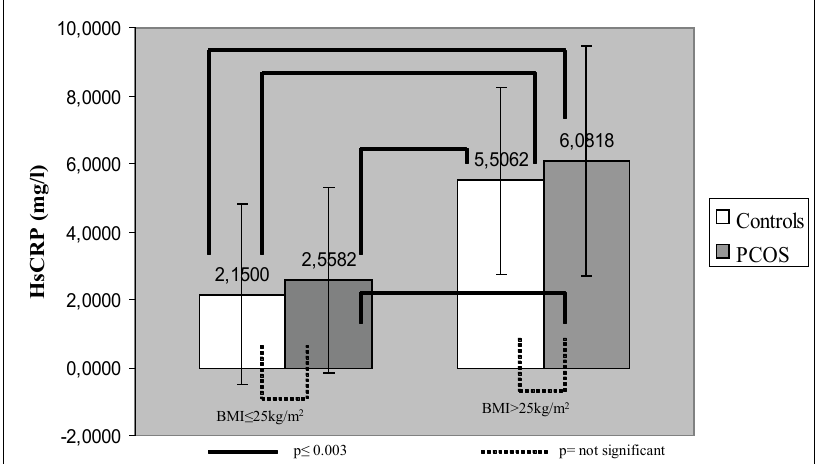
Data are given means ± SE, p<0. 05 statistically